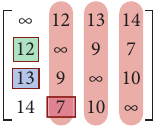
Figure 7: Discarding column 3.